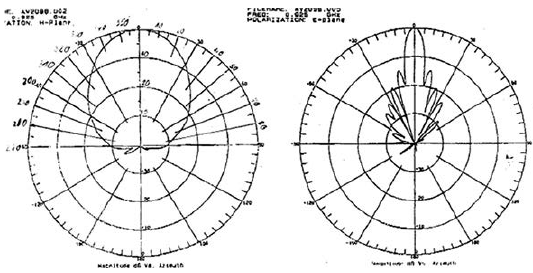
Fig. 2. Directivity diagram of antenna AV2098 for mobile cellular communications